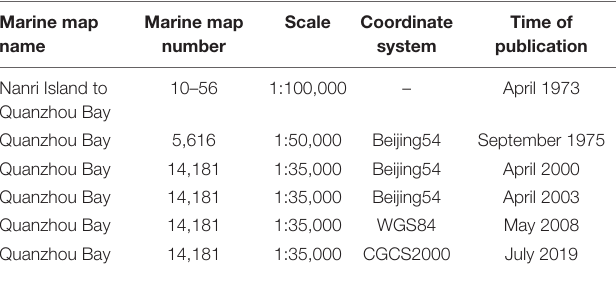
TABLE 1 | Status of historical marine map data.